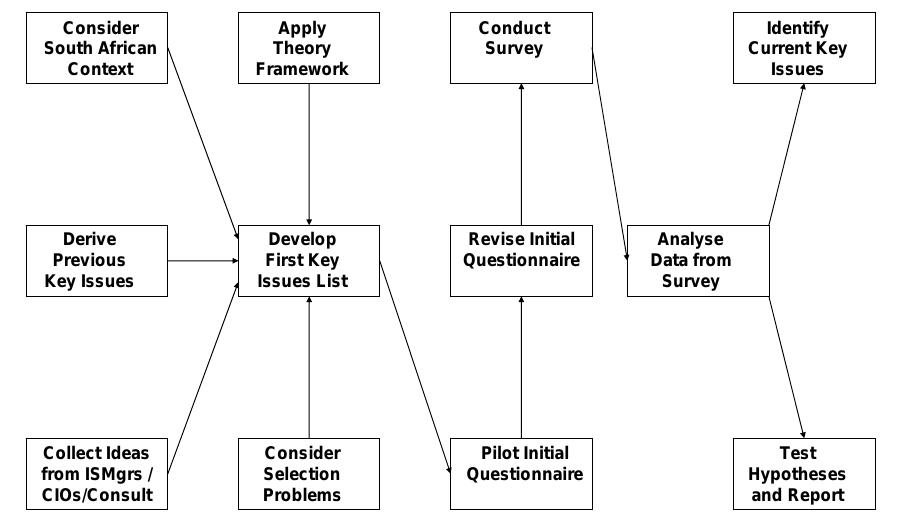
Figure 2: Research Method Followed (adapted from Gottschalk et al ., 2000) Data was protected with network and SQL database passwords, and questionnaire design restricted the choices of the user to the maximum and minimum values for each question. Calculations were performed in Excel 2002 to establish demographic and other information, and Statistica v6,0 was used for relevant statistical tests. The results and commentary are shown in the following sections.